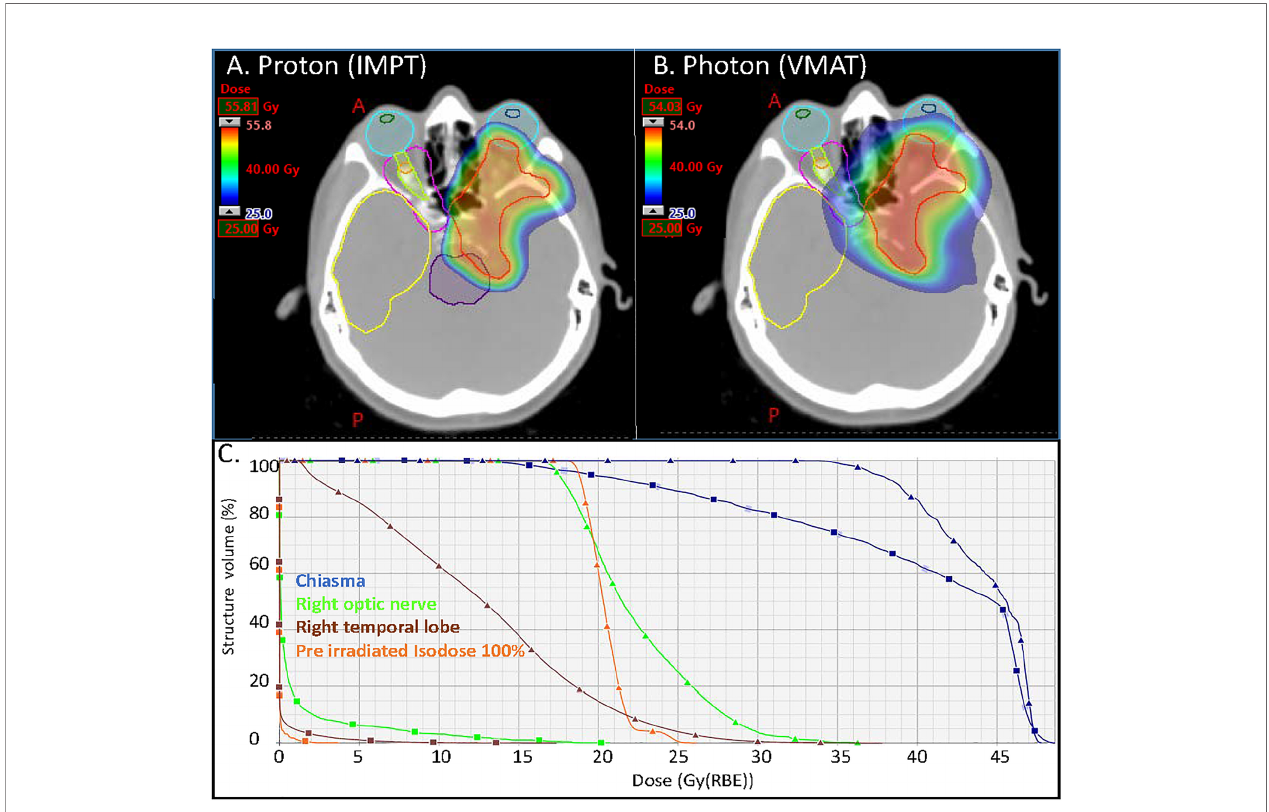
FIGURE 2 | Axial distributions for the (A) proton (IMPT) and (B) photon (VMAT) plans. In magenta and orange the isodoses lines of the pre irradiation (50% and 100% of 54 Gy respectively); (C) DVHs of the optic nerve right, chiasma, right temporal lobe and ROI de fi ned within the 100% isodose line of the pre irradiation (square markers for the proton plan and triangular markers for the photon plan). VMAT, Volumetric modulated Arc Therapy (photon plan); IMPT, Intensity Modulated Proton Therapy (Proton